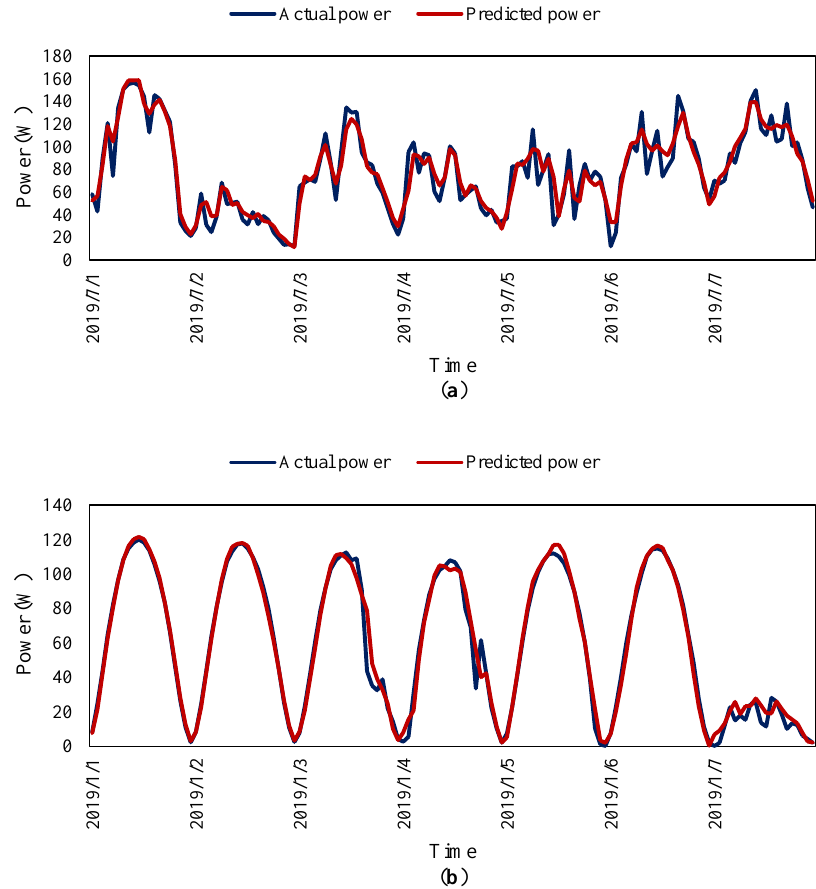
Figure 14. Real and predicted power output diagram. ( a ) The EN-1 model for one week in the summer and ( b ) the EN-1 model for one week in the winter.